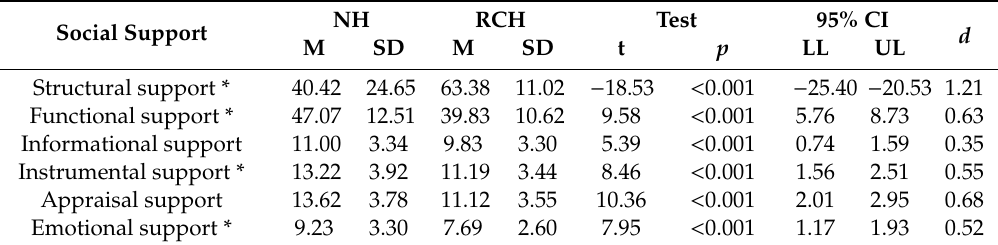
Table 5. Comparison of social support depending on the type of care